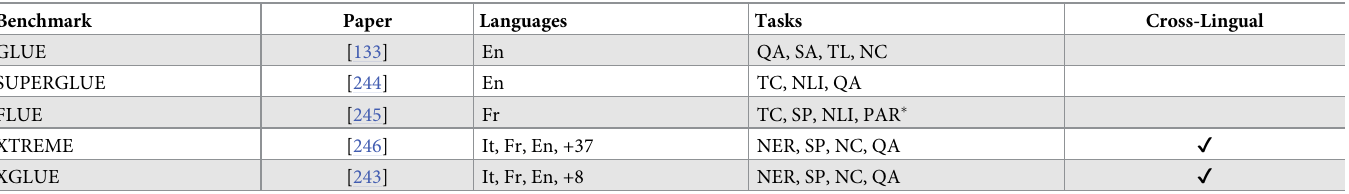
Table 8. Linguistic